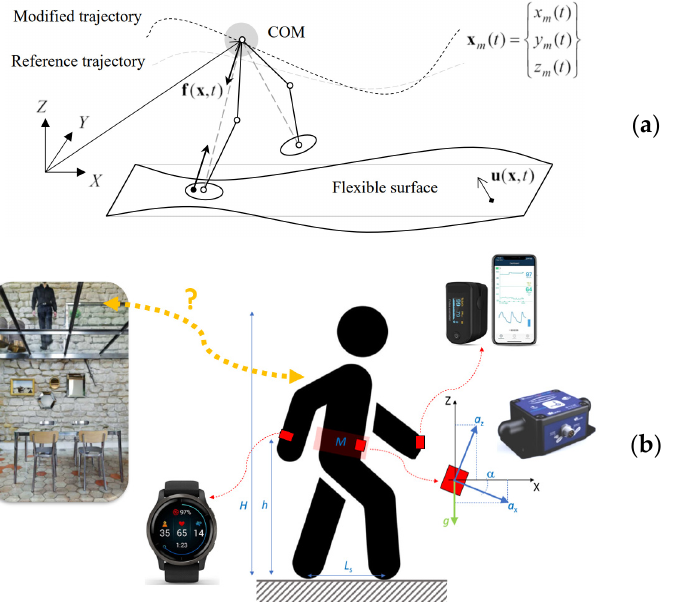
Figure 1. Example of ( a ) a mechanical model of walking body motion on a flexible system and ( b ) a pilot human comfort experimental analysis (figures adapted with permission from [18] under the terms and conditions of CC ‐ BY license agreement).